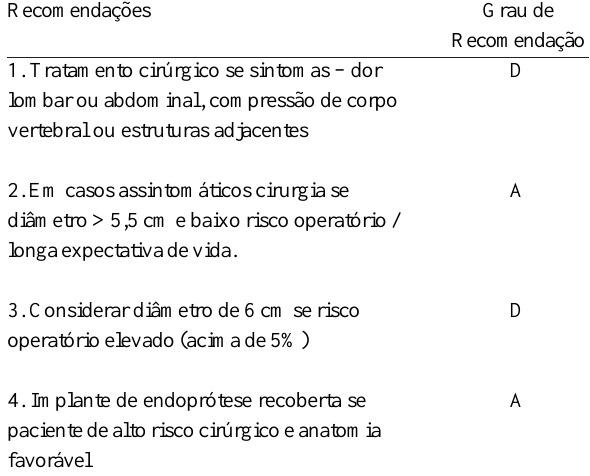
Tabela 5. Critérios de intervenção nos Aneurismas Aórticos